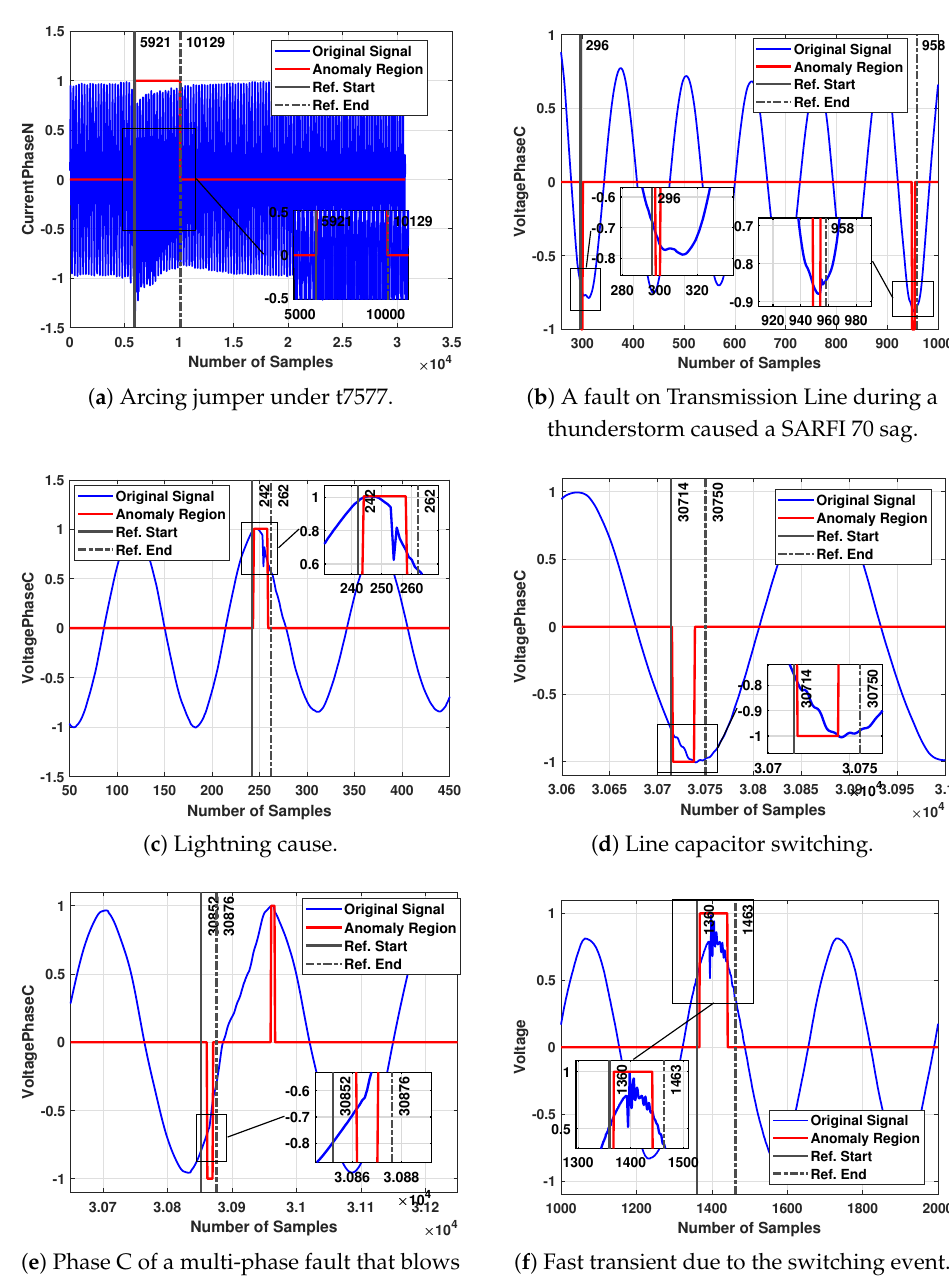
Figure 2. Detection performance of the proposed energy detector approach for Grid Signature Library waveforms [19]. Red lines show the output of the algorithm, and blue lines represent the original captured waveform. Black lines show the reference anomaly start sample and end sample,